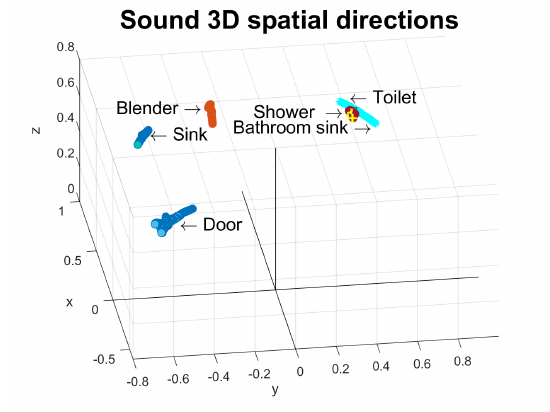
Figure 8. Spatial 3D direction from collected sound